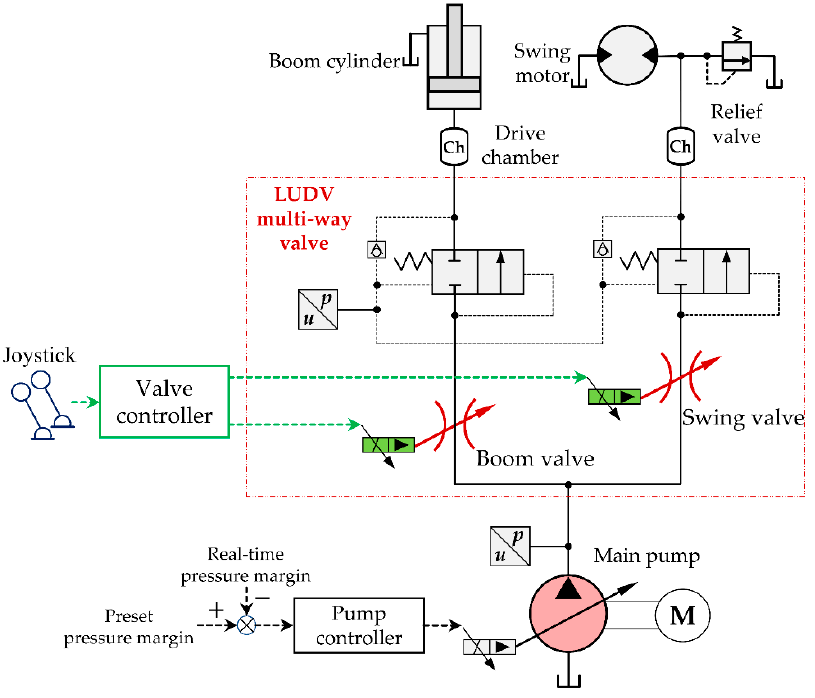
Figure 1. Hydraulic schematic of swing-boom LUDV system.